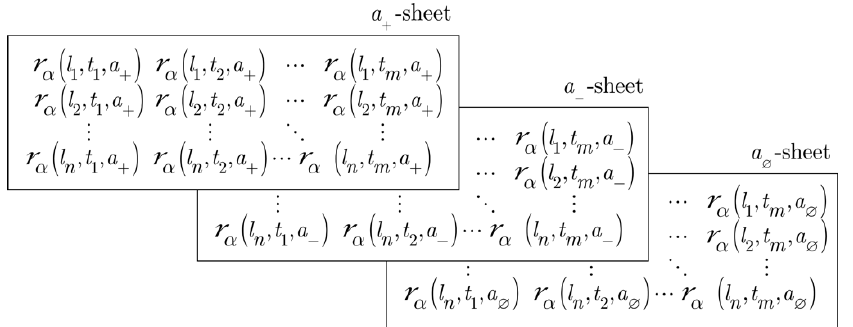
Figure 2. Three binary subrelations associated with R ( L , T , A ) , viz. R + ( L , T ) , R − ( L , T ) , and R ∅ ( L , T ) , which correspond to the a + -, a − -, and a ∅ -sheet in the figure, respectively. They are formed by projections of the respective ternary subrelations R + ( L , T , A ) , R − ( L , T , A ) , and R ∅ ( L , T , A ) onto the binary reference set L × T